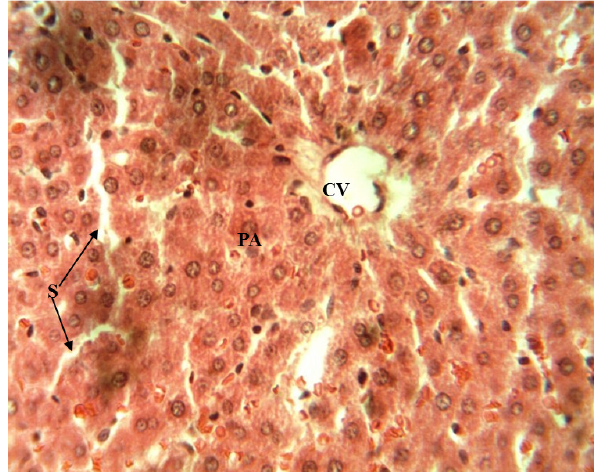
Fig. 6. Photomicrograph of a section of the liver of group C (800 mg/kg) rats (stained with H & E; × 10). Seen are plates of hepatocytes separated by sinusoid in the paracentral area surrounding a central